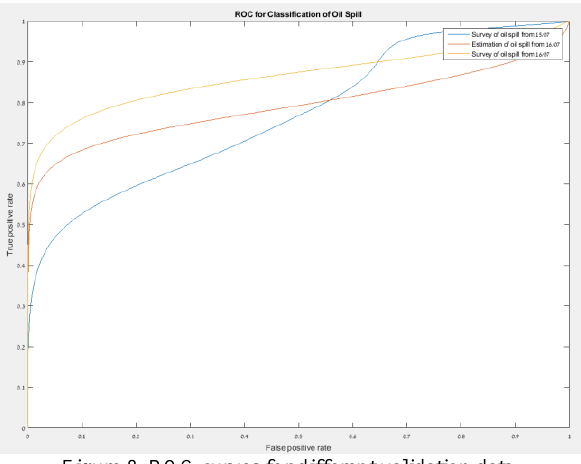
Figure 8. ROC curves for different validation